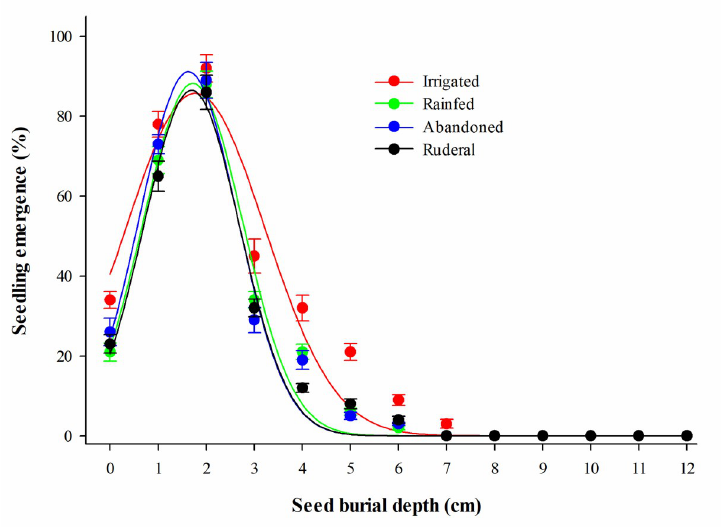
Fig 7. The influence of different seed burial depths on seedling emergence of Conyza stricta Willd. The vertical bars present standard errors of means (n = 10).